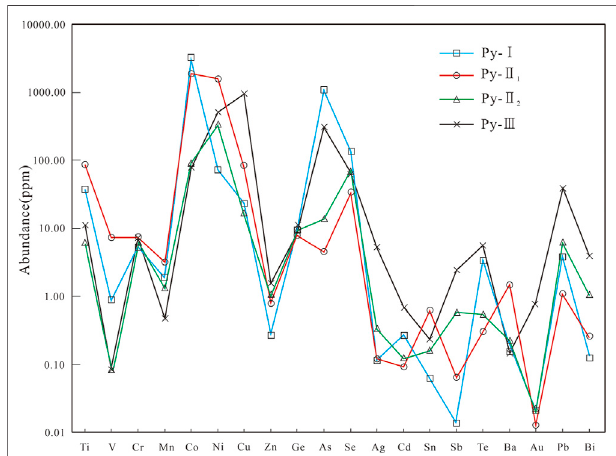
FIGURE 7 | The average trace element composition of pyrite in different mineralization stages in the Tuwu porphyry Cu deposit in eastern Tianshan, Xinjiang, NW